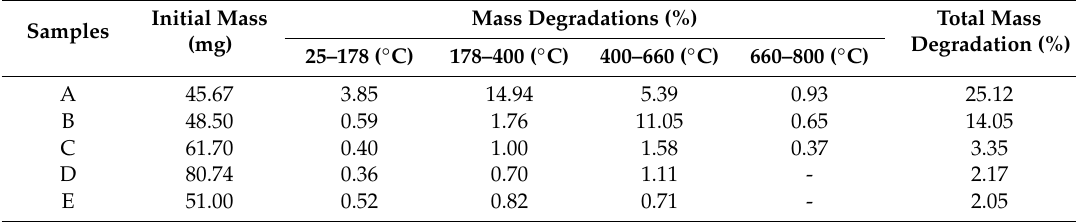
Table 3. The changes of scaffold mass, from TGA measurement.